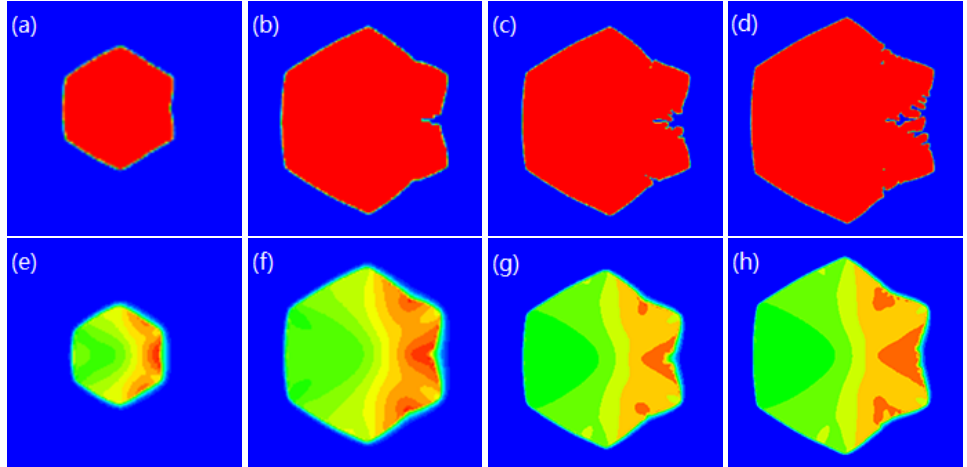
Figure 13. When K 0 = 0.8, v x = 0, v y = 1.5, the simulated shape of spherulites and the corresponding temperature field distribution affected by the flow velocity. (( a – d ) is the crystalline morphology of the polymer after adding the flow rate and ( e – h ) is its corresponding temperature